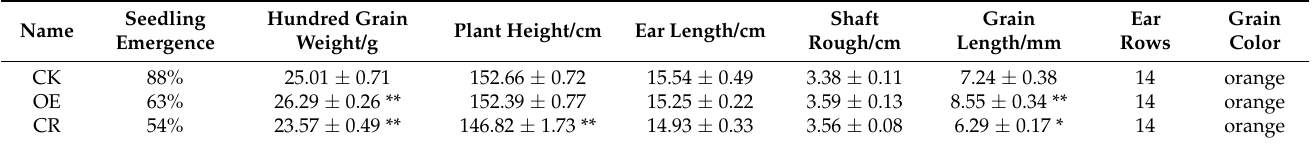
Table 1. Character survey of T 2 transgenic